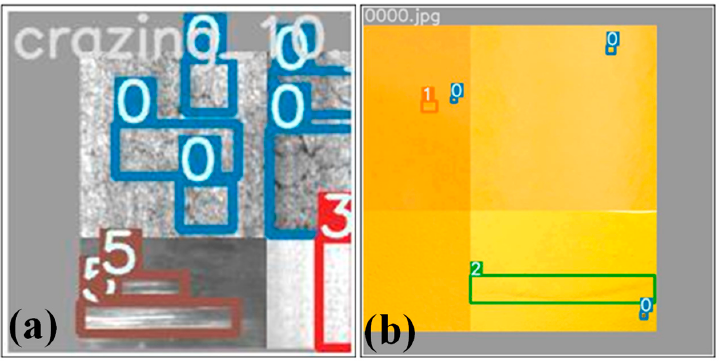
Figure 3. ( a ) NEU Data augmentation ( b ) Paint Data augmentation. Numbers are class indexes.